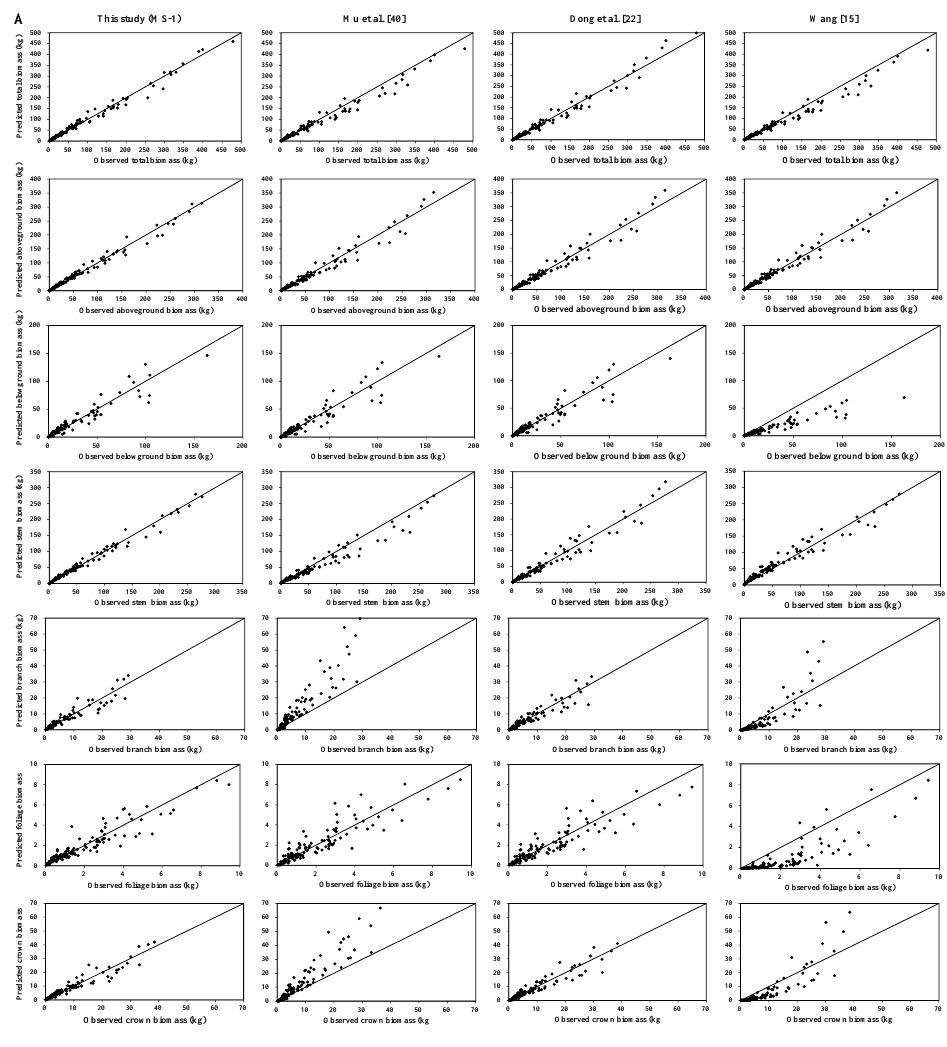
Figure 5. Mean absolute bias (MAB) of the four methods of estimating the individual biomass of ( A ) Dahurian larch and ( B ) white birch, where TB, AB, RB, SB, BB, FB, and CB stand for total, aboveground, root, stem, branch, foliage, and crown biomass, respectively.